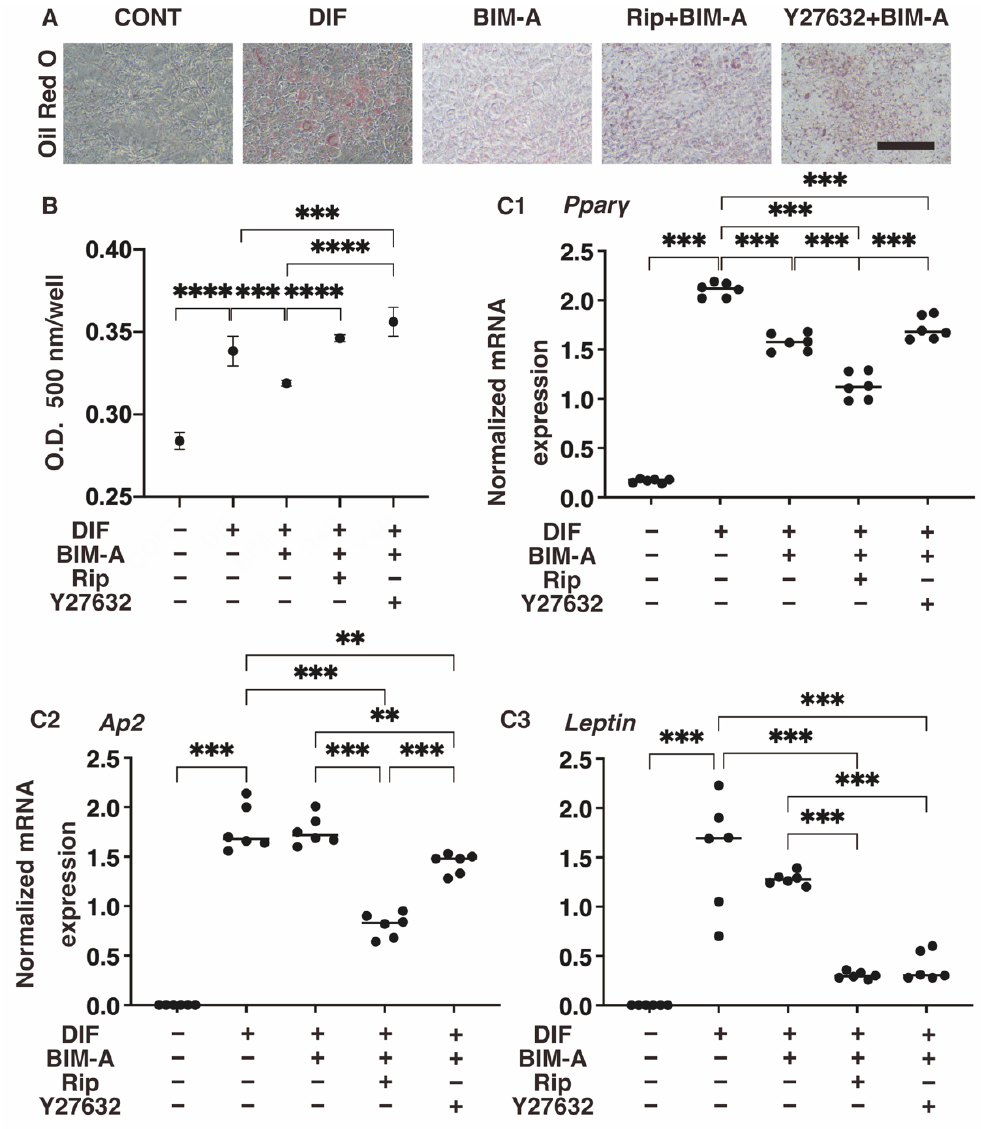
Figure 2. Additional effects of ROCK-i on BIM-A during the adipogenesis of 2D planar cultured 3T3-L1 cells. The 2D planar cultures of 3T3-L1 cells were cultured under several conditions: pread- ipocytes of 3T3-L1 cells (CONT) or their adipogenic differentiation (DIF) with or without the com- bination of 100 nM BIM-A (BIM-A) and ROCK-i (10 μ M Ripasudil (Rip) or 10 μ M Y27632). These specimens were subjected to analysis by Oil Red O lipid staining (panel ( A ); representative phase contrast images, scale bar: 100 μ m, and panel ( B ); their staining intensities, O.D.) and qPCR of the master adipogenesis gene, Ppar γ (panel ( C1 – C3 )). All experiments were performed in triplicate us- ing fresh preparations, each consisting of 5 specimens. Data are presented as the arithmetic means ± the standard error of the mean (SEM). ** p < 0.01, *** p < 0.005, **** p < 0.001 (ANOVA followed by a Tukey’s multiple comparison test). 3.1.2. The Quantitative PCR Analysis of ECMs Including Collagen (Col) 1, 4 and 6, and Fibronectin (Fn) (Figure 2), and Real-Time Cellular Metabolic Analysis (Figure 3) In terms of the mRNA expression of ECMs (Figure 3), a marked downregulation or upregulation was observed in Col1 and Fn , or Col4 and Col6 , respectively, upon DIF+ ad- dition. In the presence of BIM-A, although the DIF+-induced changes in these ECMs were not significantly altered, all four ECM molecules were substantially downregulated by the addition of ROCK-i to BIM-A. Real-time cellular metabolic measurements (Figure 4)